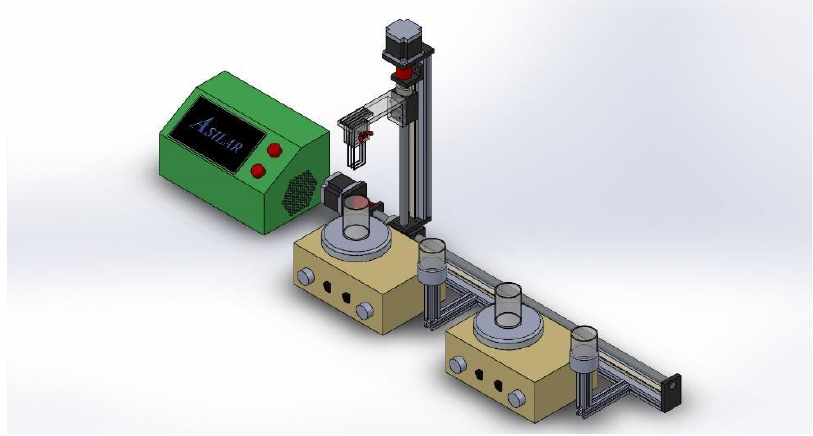
Figure 3. 3D representation of the SILAR prototype.